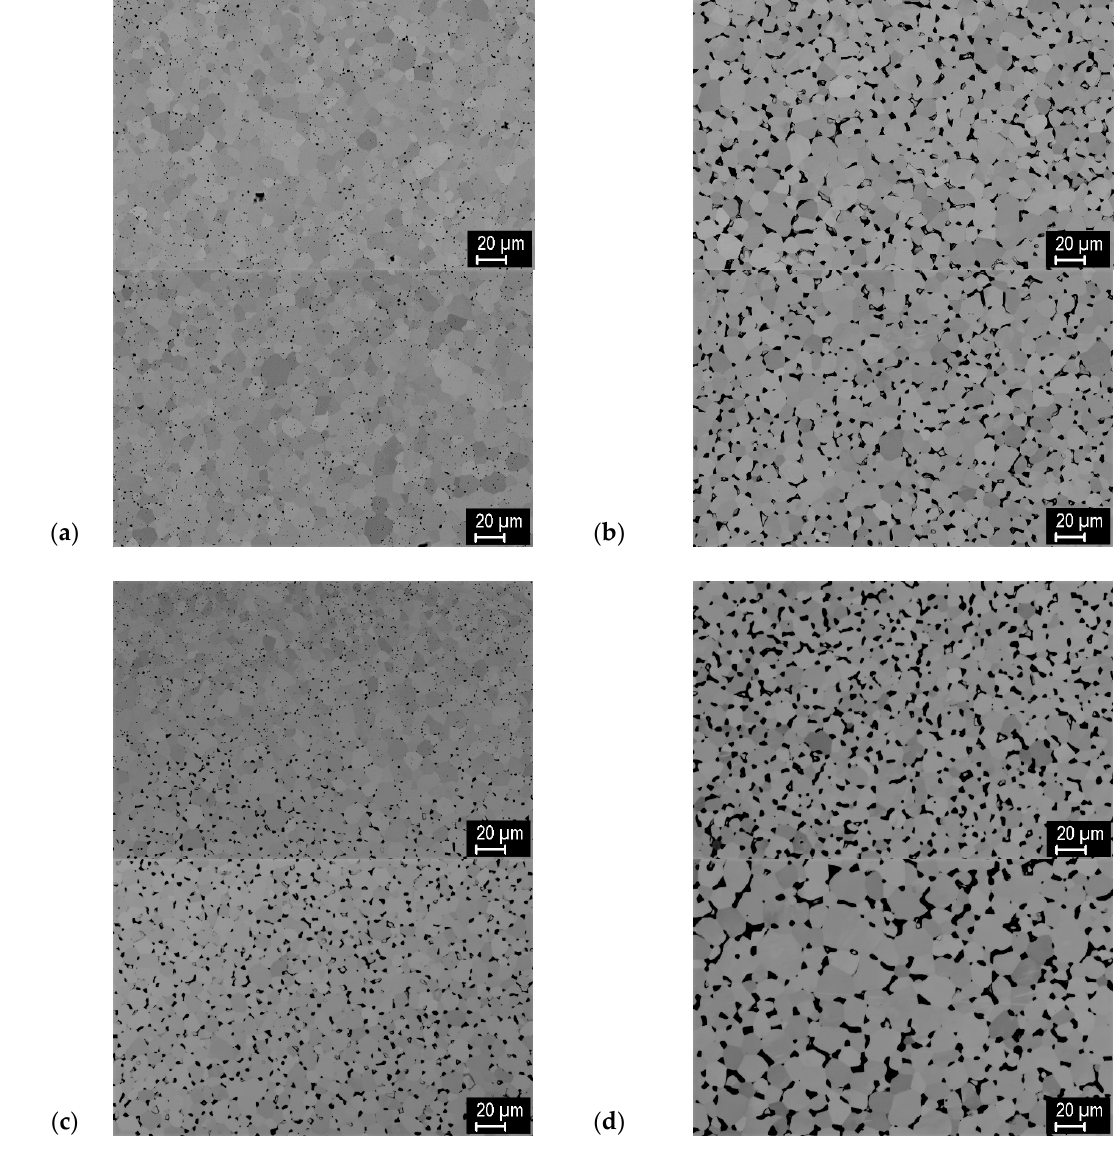
Figure 6. Representative microstructures of the CLC15 ( a ), CLW15 ( b ), ULC15 ( c ) and ULW15 ( d ) samples (top and middle regions).